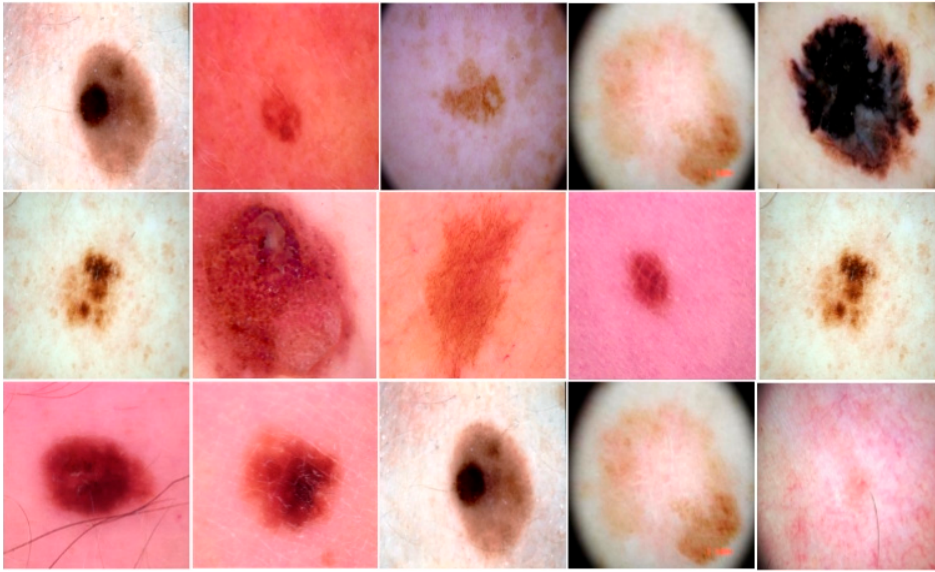
Figure 4 . Some samples from the dataset . Figure 4.